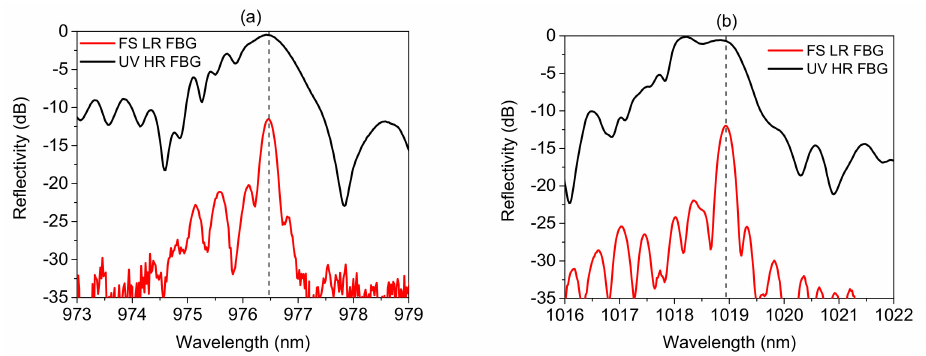
Figure 2. Reflection spectra of FBG pairs: UV-inscribed high-reflection (HR) FBG and FS-inscribed low-reflection (LR) FBG used as cavity mirrors for the 1st Stokes wave at ~976 nm ( a ) and for the 2nd Stokes wave at 1019 nm ( b ) at ~940 nm LD